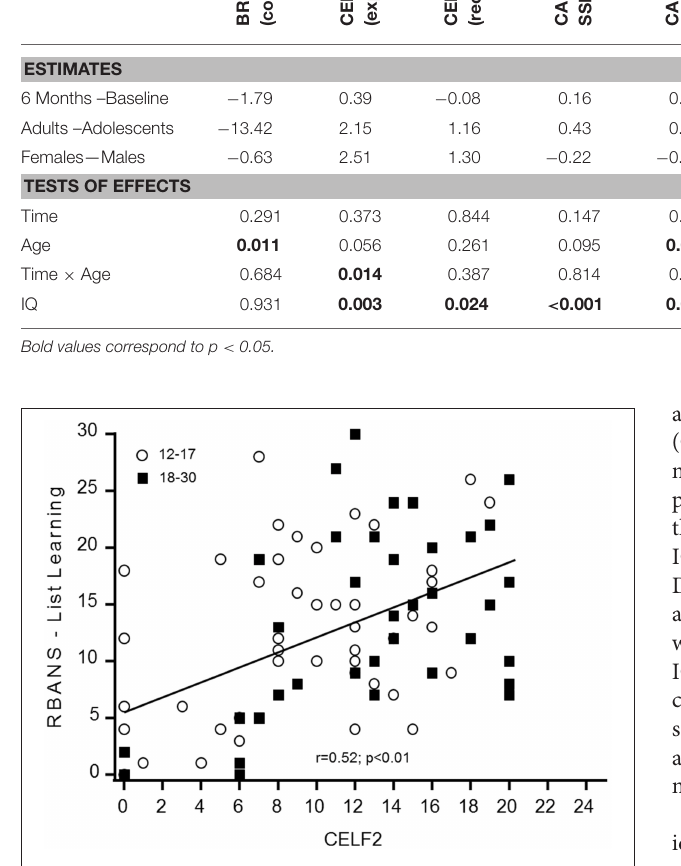
FIGURE 1 | RBANS List Learning scores and CELF-P-2 Word Classes expressive